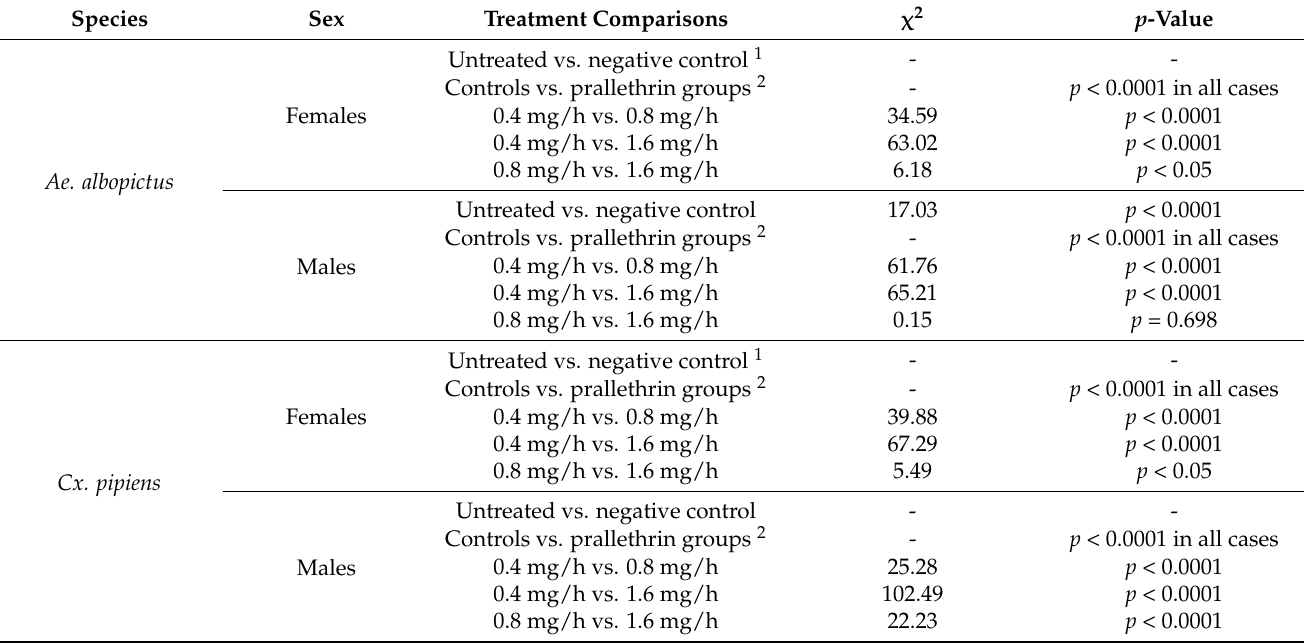
Table 3. Comparison of within species knockdown for female and male Ae. albopictus and Cx. pipiens across the five treatment groups in Experiment